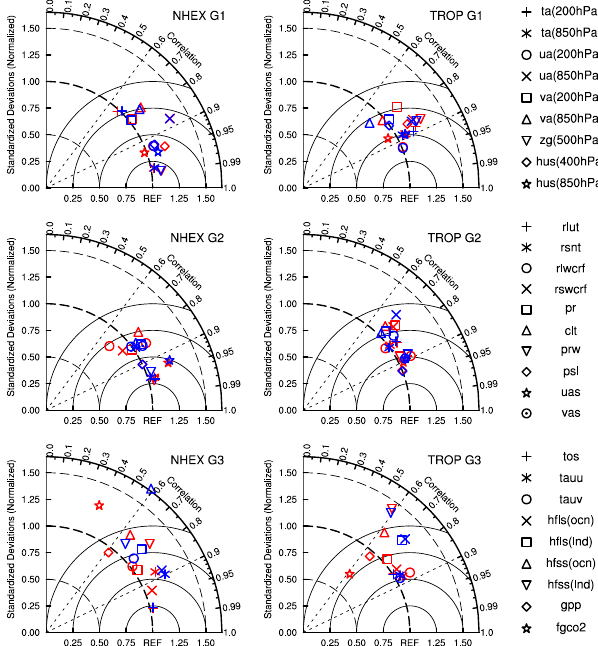
Figure 2. Multivariate Taylor diagrams of the 20th century annual cycle climatological (1986–2005) for the tropical (20 ◦ S–20 ◦ N, TROP) and the northern extra-tropical (20–90 ◦ N, NHEX) zones. Each field is normalized by the corresponding standard deviation of the reference data, which allows multiple fields to be shown in each sub-figure. Red/Blue markers represent the simulation field evalu- ated against the Reference1/Reference2 data defined in Table